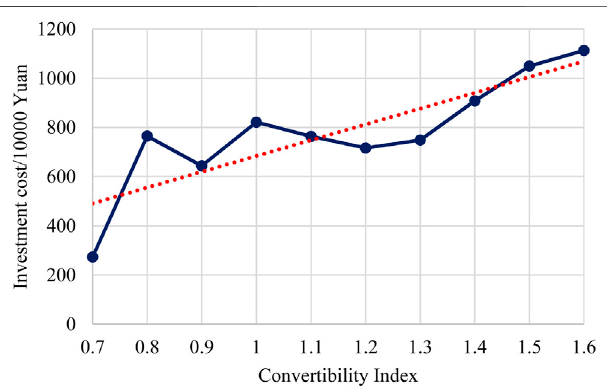
FIGURE 8 | Annual total cost with different CIs.